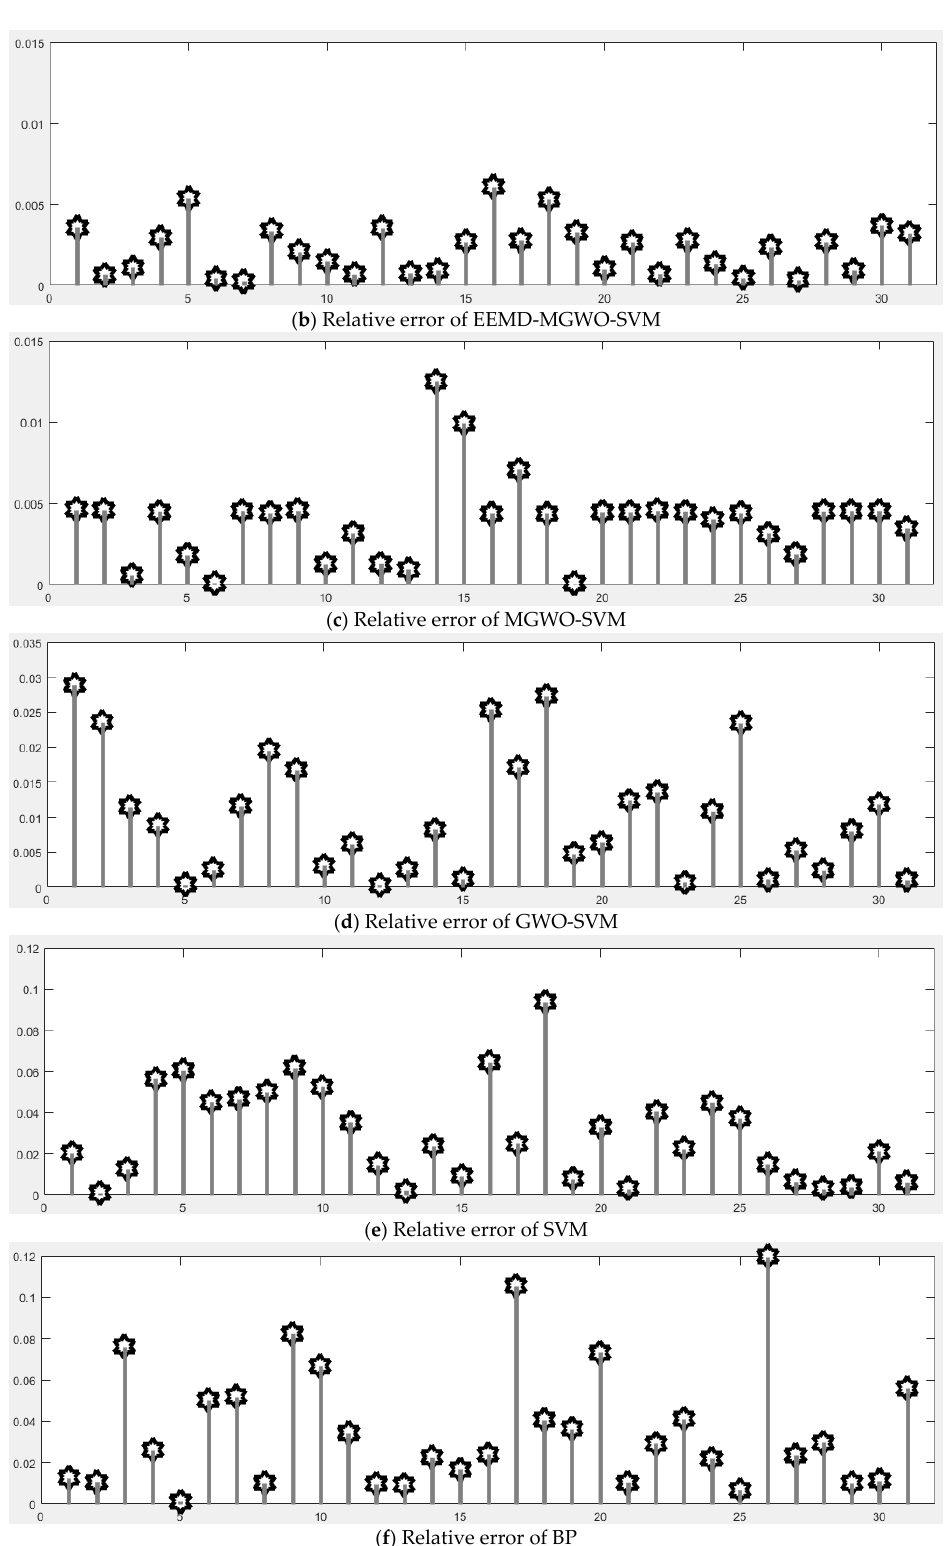
Figure 10. The relative errors of different models: ( a ) CEEMDAN ‐ MGWO ‐ SVM; ( b ) EEMD ‐ MGWO